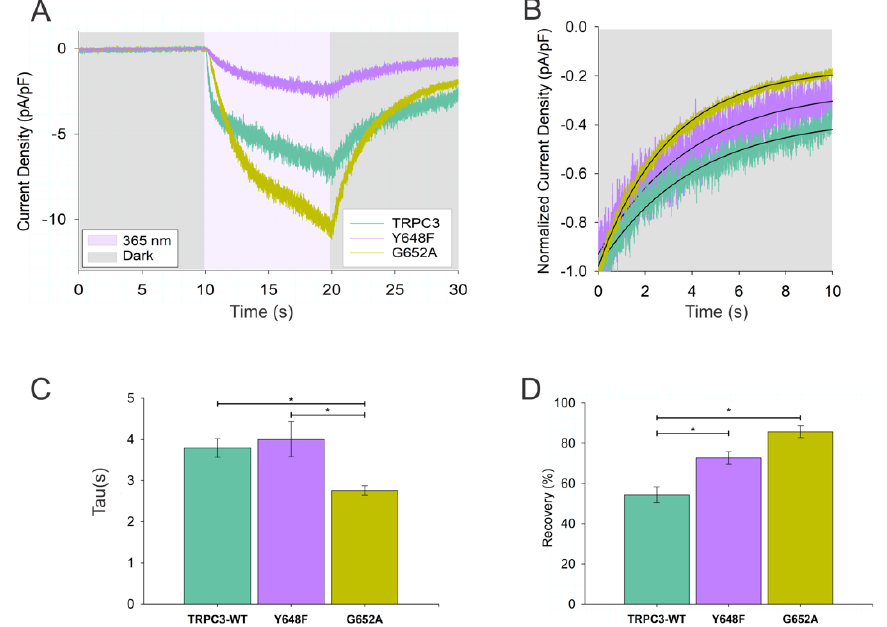
Figure 4. Characteristics of TRPC3 channel thermal relaxation-mediated deactivation is altered by mutation in the L2 region. ( A ) Representative current traces showing gating kinetics induced by thermal relaxation of OptoDArG (30 μM) in TRPC3 − WT (green), Y648F (violet), and G652A (yellow) after UV illumination was switched off (dark) in a whole − cell gap-free recording (holding potential: −40 mV, baseline adjusted to 0 mV, normalized by capacitance). ( B ) Exponential fit of representative normalized time courses of TRPC3-WT (green), Y648F (violet), and G652A (yellow) current deactivation after UV illumination was switched off (dark). ( C , D ) Bar charts illustrating the deactivation time constant (Tau; ( C )) and the percentage of the recovery to basal conductance after UV was switched off (dark; ( D )); TRPC3 − WT and TRPC3 mutants. Number of biological repetitions for each condition ≥ 6. The data are the means ± SEM; two − tailed t − test or Mann–Whitney test was applied; * p < 0.05.